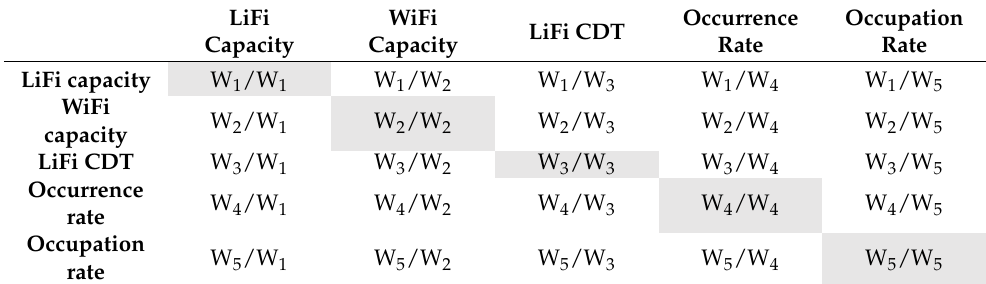
Table 6. Pairwise comparison